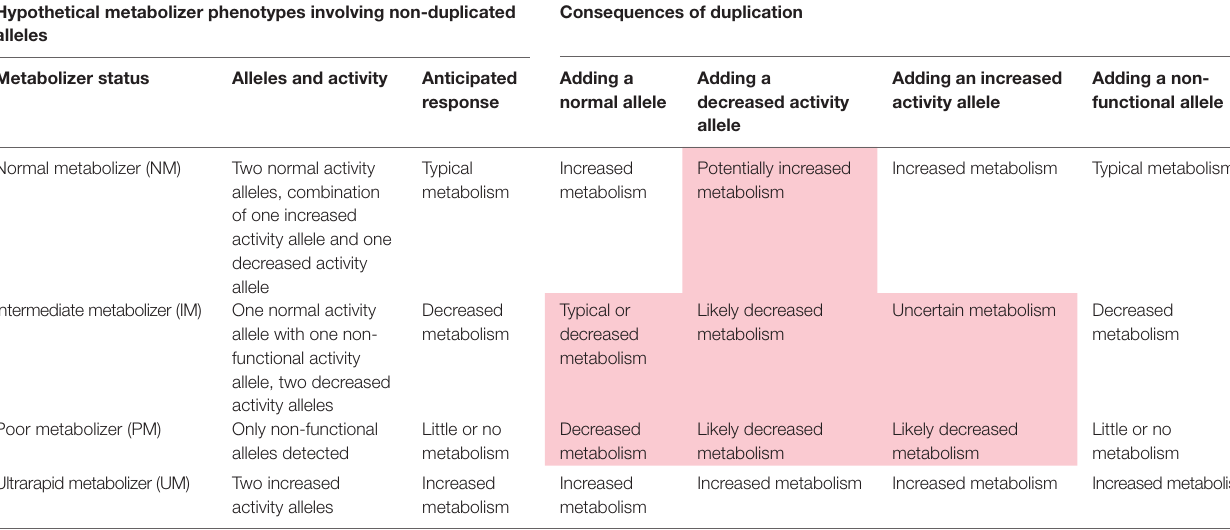
TABLE 1 | Potential consequences of duplication for interpreting patient metabolizer status. Hypothetical metabolizer phenotypes involving non-duplicated